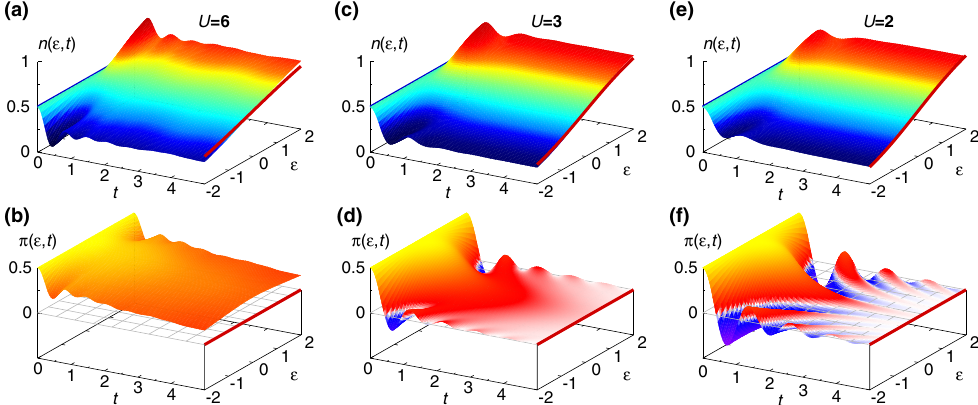
FIG. 2. Diagonal component n ð ϵ k ; t Þ ¼ h c † k c k i of the momentum occupation [(a), (c), and (e)] and off-diagonal component Re π ð ϵ k Þ ¼ ¯ k are pairs of single-particle states coupled by a staggered potential, plotted for quenches to three h c † k c ¯ k i [(b), (d), and (f)], where k and different values of U as a function of the energy ϵ k ranging from − 2 to 2 in the band of the Bethe lattice. The bold lines indicate momentum distributions obtained in the (paramagnetic) equilibrium state at the same energy. Note that the symmetry of the curves for ϵ → − ϵ is a consequence of particle-hole